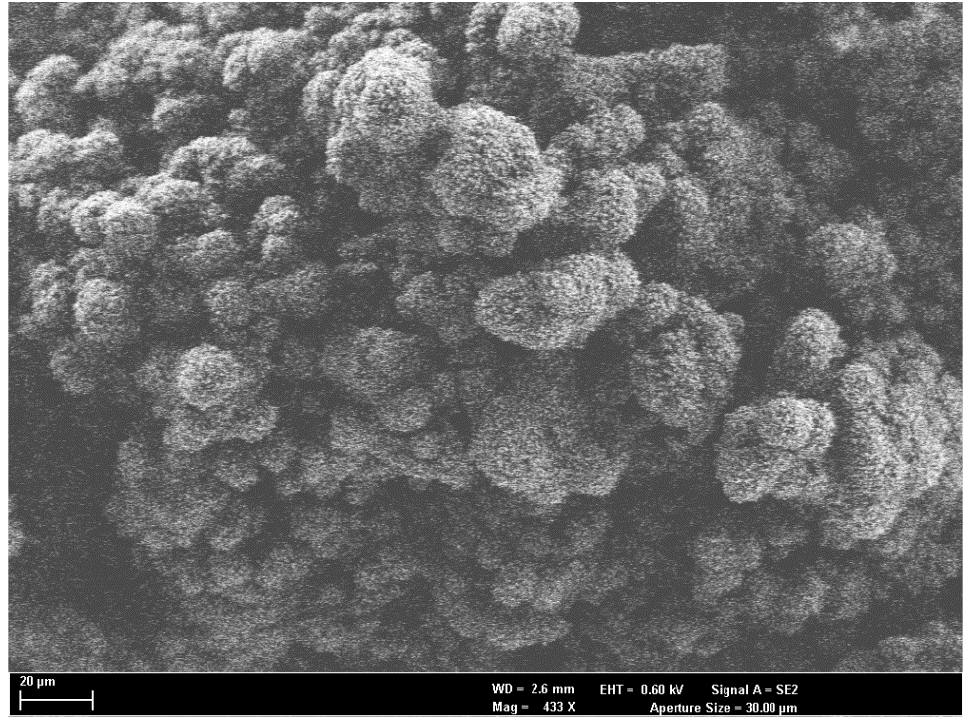
Figure 6. SEM picture of the prepared fine grained ice. The surface of the ice particle is covered with frost and includes fissures and cracks indicating a large surface